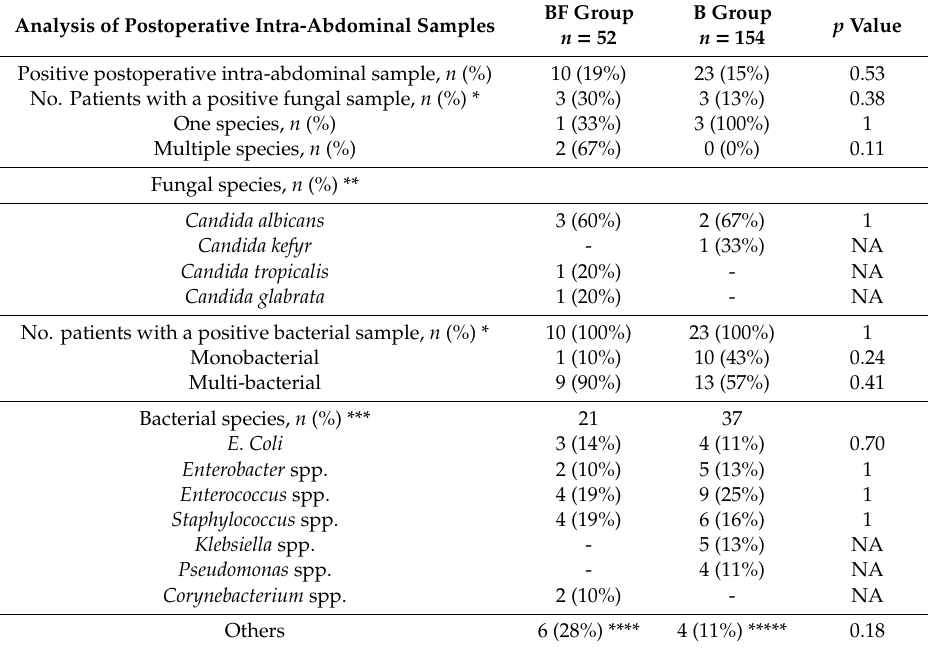
Table 5. Analysis of postoperative intra-abdominal